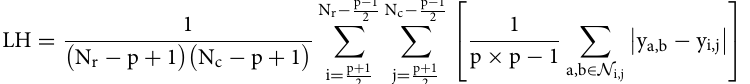
plots with a reasonable resolution, the size of DeepInsight images are much larger than that of IGTD images, 227 × 387 = 87, 849 pixels (Fig. 2c) and 380 × 387 = 147, 060 pixels (Fig. 2f) vs. 50 × 50 = 2, 500 pixels (Fig. 2a and Fig. 2d). The large images generated by DeepInsight may require more memory and time to train the prediction model in subsequent analysis. Similar to IGTD, REFINED also generates compact image representations without any blank area. Fig. 2b and Fig. 2e show the images that REFINED generated for the SNU-61 cell line and Nintedanib, respectively. To investigate the difference between IGTD and REFINED images, we used the following local heterogeneity (LH) measure to quantitatively evaluate the preservation of feature neighborhood structure in image representations.